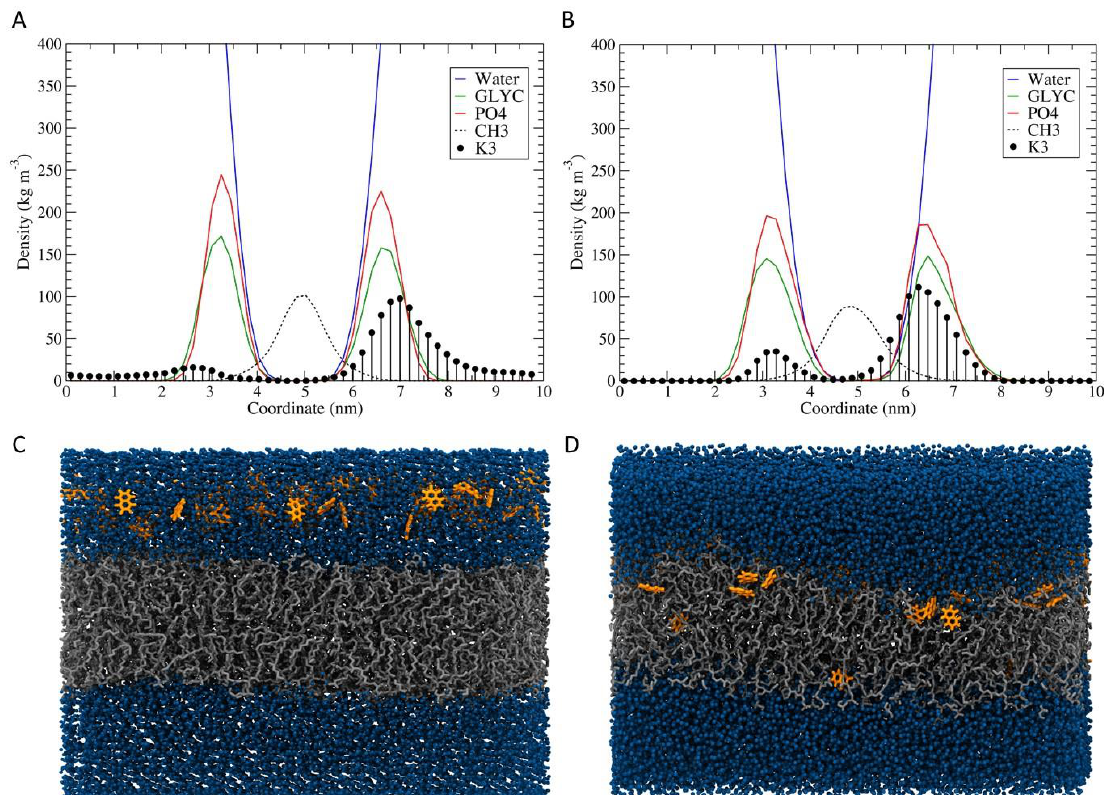
Figure 9. Average density profiles and snapshots conformations for the beginning and the end of menadione with POPG bilayer simulation. Initially ( A , C ) The menadione molecules (orange) were distributed above the membrane (grey). In the end ( B , D ), several went through the membrane and allowed the entry of water molecules (blue spheres) in the hydrophobic regions. The density curves shown are: water (blue lines), phosphate groups (red), glycerol groups (green), acyl chains (black dots), and menadione molecules (black